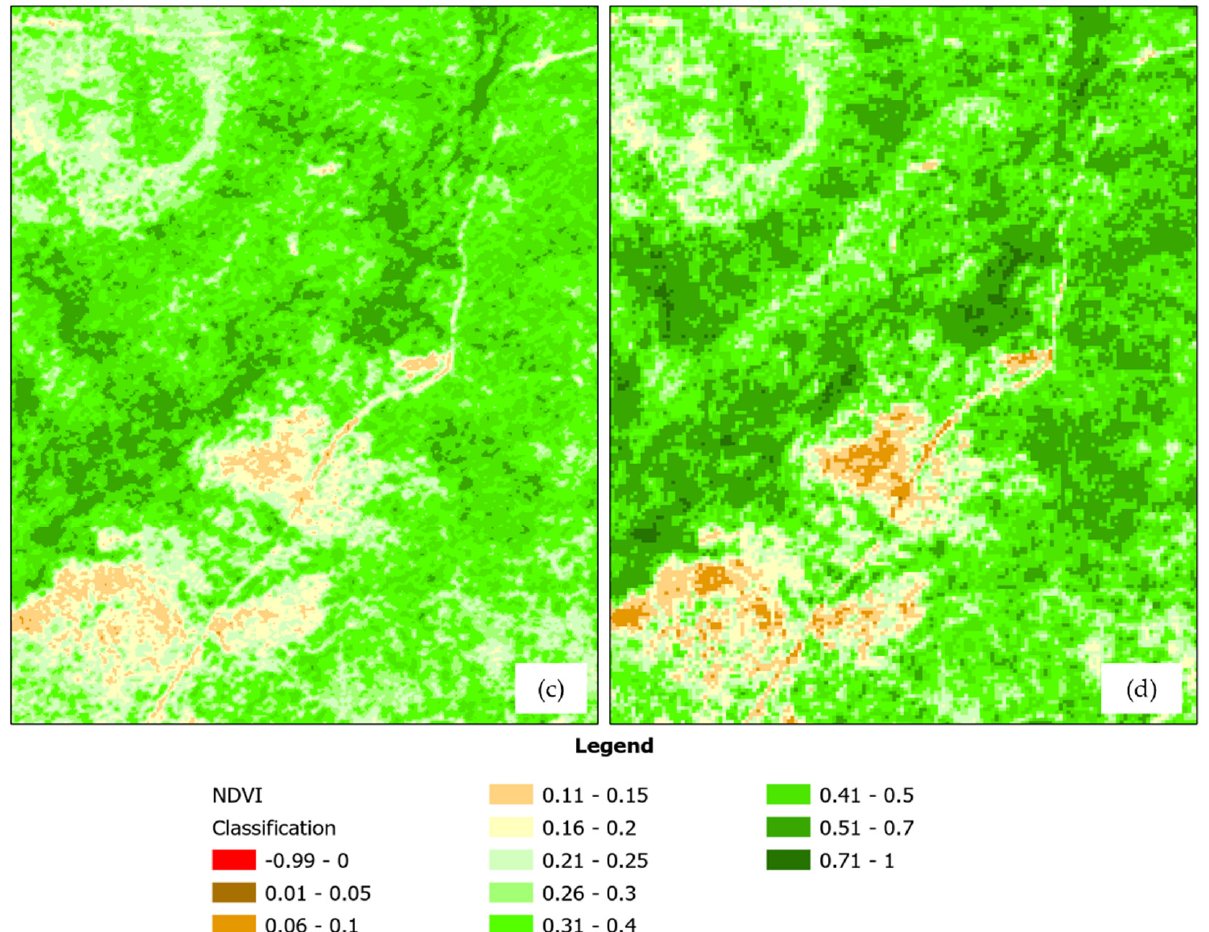
Figure A1. Comparing the subjective map user visual acuity of Sentinel-2 (S2) images (10 m spatial resolution) and RapidEye (RE) images (3 m) for an area within the Minerva Hills National Park (located Northwest of the Queeensland, Australia town of Springsure: lattitude −24.12, longitude 148.09): ( a ) RE true-colour 25 September 2017, ( b ) S2 true-colour 30 July 2018; ( c ) RE Normalised Difference Vegetation Index (NDVI); and ( d ) S2 NDVI.